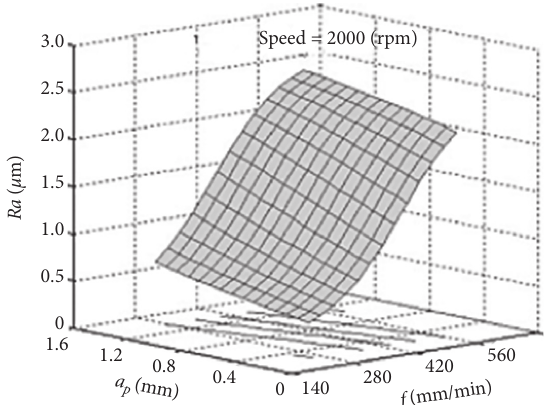
Figure 14: Influence of feed rate and doc on Ra for constant spindle speed of 2000rpm.